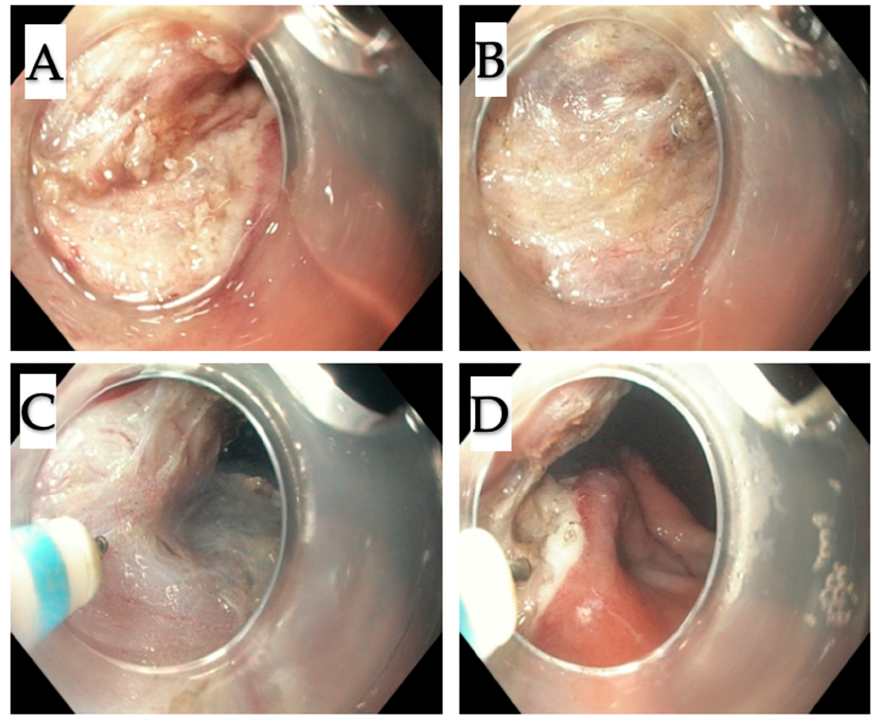
Figure 4. Step two. ( A – D ) Subsequent layers below the tumor were cut with the incision of Figure 4. Step two . ( A – D ) Subsequent layers below the tumor were cut with the incision of muscularis muscularis propria. J. Clin. Med. 2019 , 8 , x FOR PEER REVIEW propria.